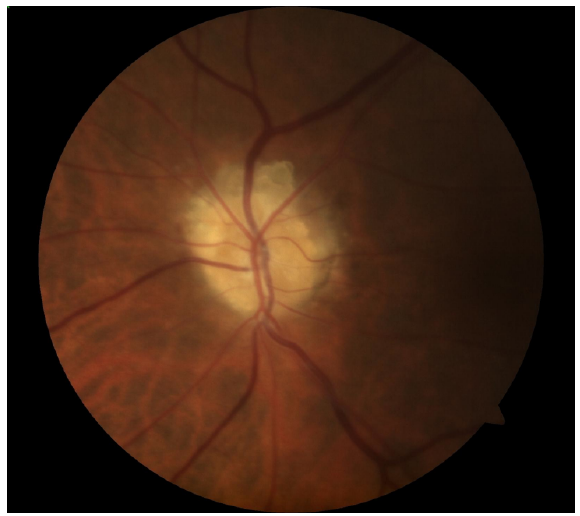
Figure 2: Optic disc left eye after optic